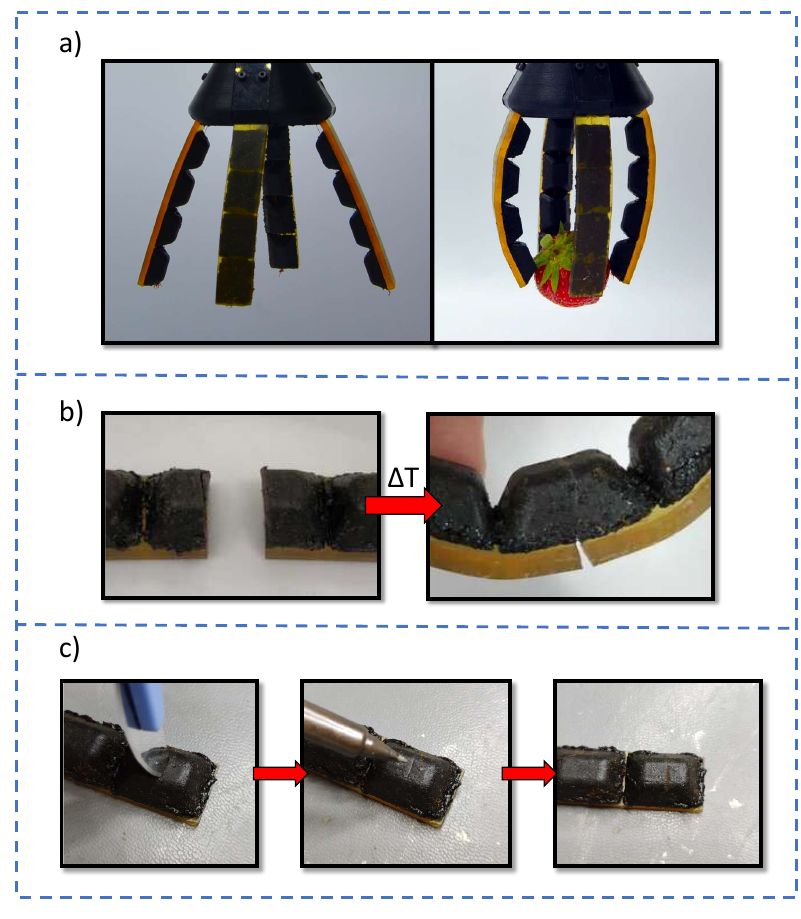
Figure 8. ( a ) Multi-material humins-based soft gripper grabbing a soft object. ( b ) Fractured multi- material finger showing great connectivity of the Humins-DA component under a healing treatment of 60 °C for 1 h. ( c ) Focalized healing-by-welding of Humins-DA upon damage at 100 °C for a few seconds.